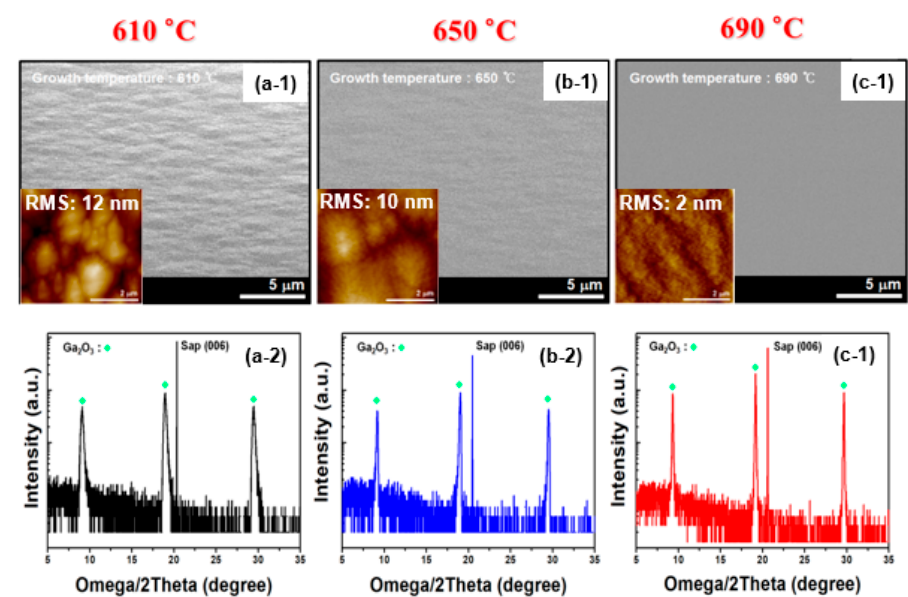
Figure 1. [Top- (a-1), (b-1), (c-1)] Top-view SEM images showing the surface morphologies of the film grown at 610, 650, and 690 ◦ C where inset figures show the corresponding 5 µ m × 5 µ m atomic force microscopy (AFM) images with measured root-mean-square roughness (RMS); [bottom- (a-2), (b-2), (c-2)] corresponding HR-XRD spectra from the samples grown at 610, 650, and 690 ◦ C. Table 1. Summary of measured and calculated reflection angle from the Ga 2 O 3 grown at 690 ◦ C on c-plane sapphire substrate (lattice parameter of orthorhombic κ -Ga 2 O 3 : a = 5.12 Å, b = 8.78 Å, c = 9.4 Å). Phase (h k l)